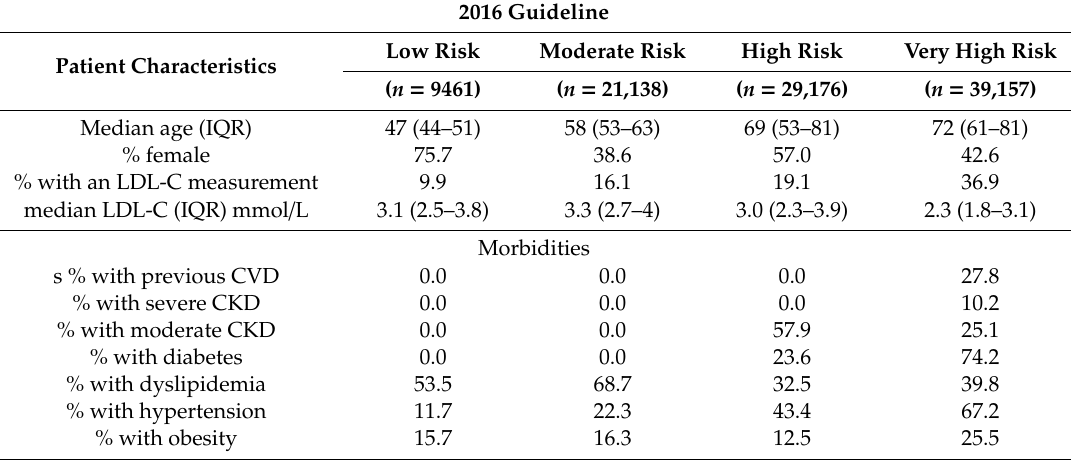
Table 1. Patient characteristics stratified according to ESC / European Atherosclerosis Society (EAS) guideline and cardiovascular (CV) risk category (total number of patients in 2016: 98,932; total number of patients in 2019: